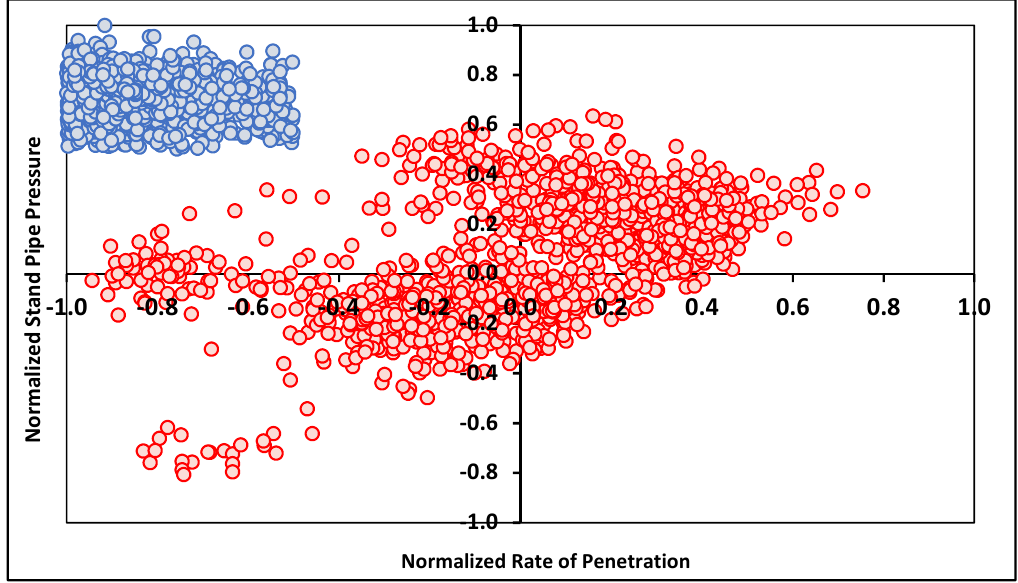
Figure 1. Example of data noise shown by clustering with the x -axis indicating normalized drilling rate of penetration (ROP) values in normalized stand pipe pressure.